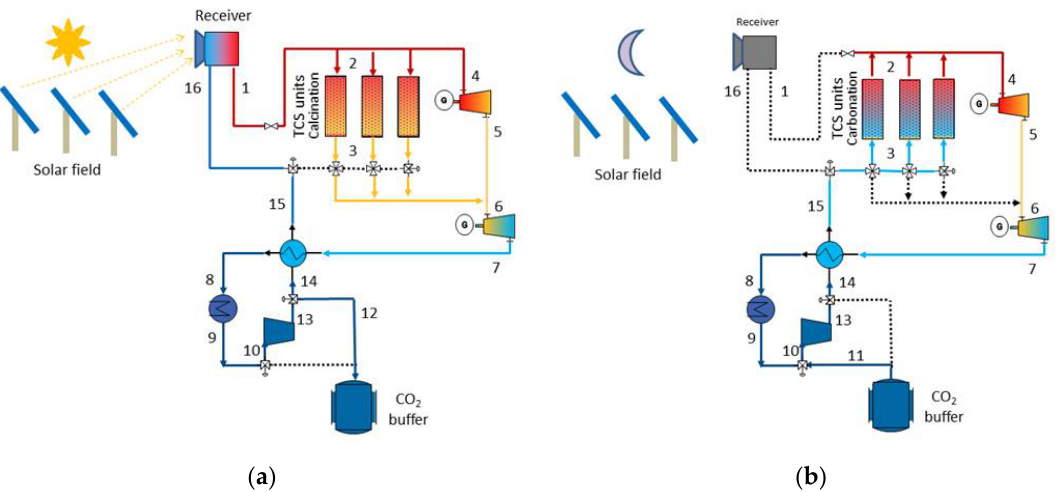
Figure 16. Conceptual scheme for the integration of a central tower plant with TCS storage unit assuming adiabatic reactor, closed process configuration, Brayton cycle-based power block. ( a ) on-sun operation; ( b ) off-sun operation.